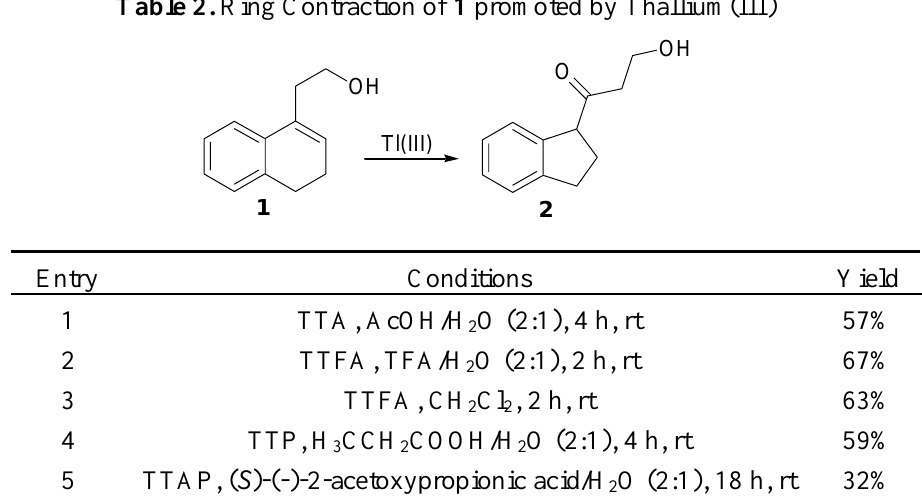
Table 2. Ring Contraction of 1 promoted by